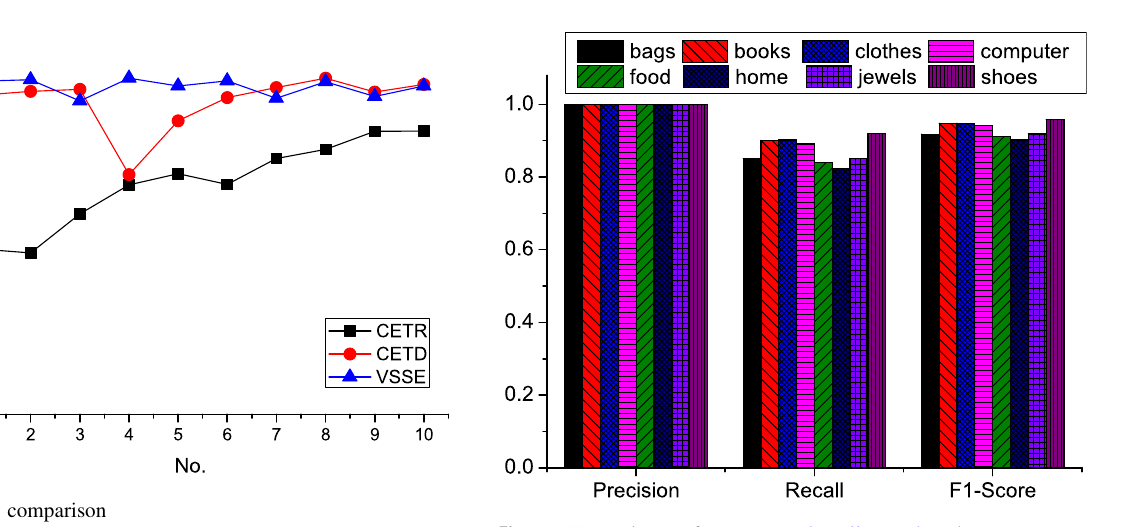
Fig. 11 Extraction performance on